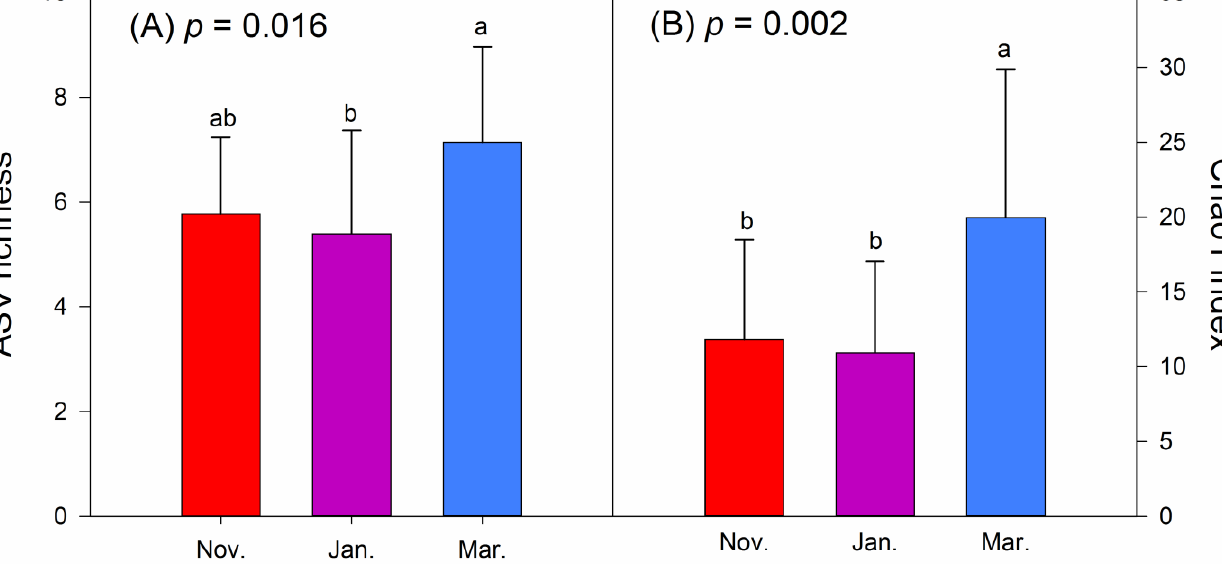
Figure 5. Alpha diversity of intestinal bacteria in wintering hooded cranes in the 3 months. ( A ) ASV richness; ( B ) Chao1 index. Letters over the bars indicate pairwise differences according to Tukey HSD test at the p < 0.05 level. Coloured bars indicate the mean value, and error bars represent the standard deviation. ASV, amplicon sequence variants.